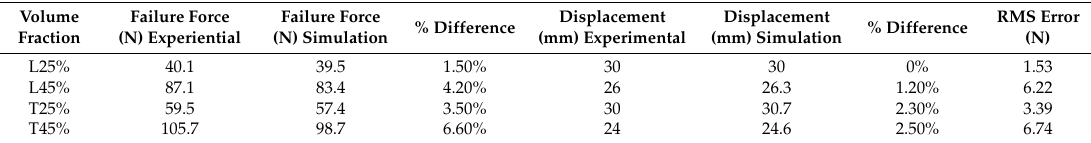
Table 6. Flexural Model Results.